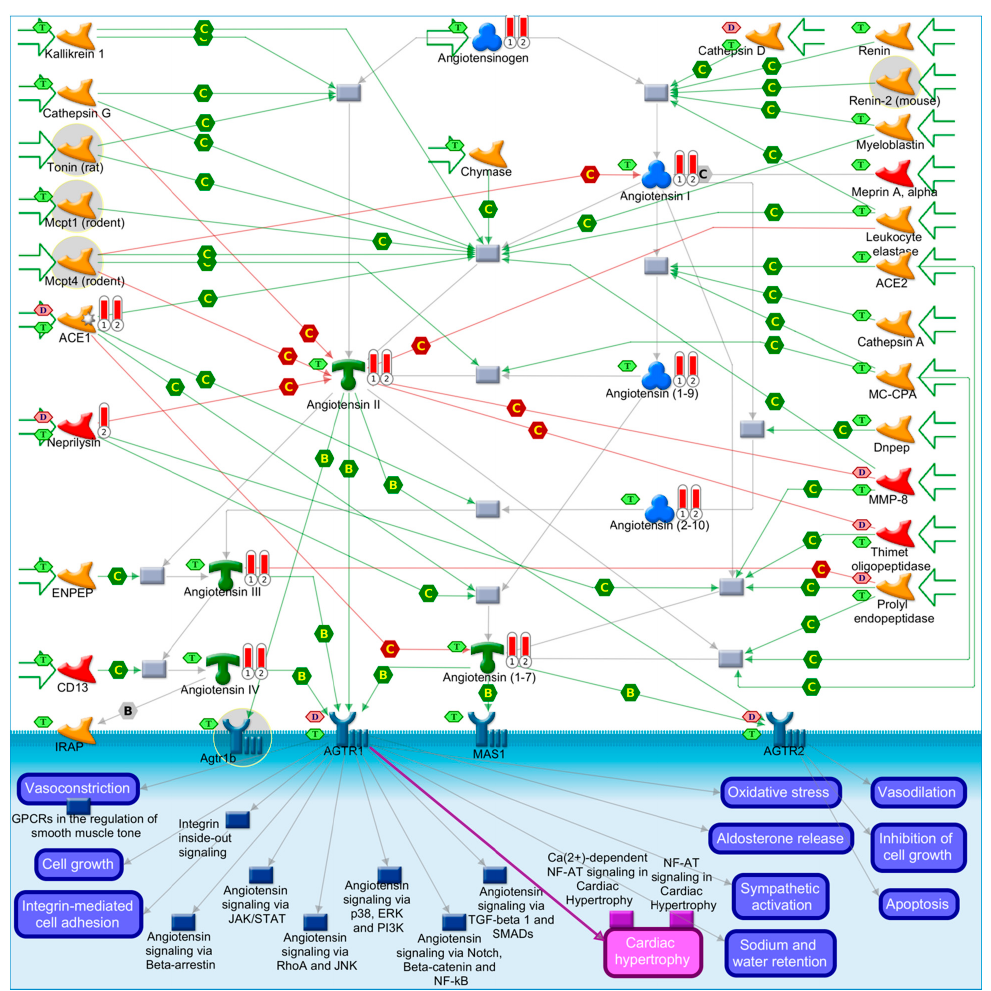
Figure 6. Top enriched pathway map for ‘common’ biomarkers of EOAD and LOAD. The pathway map representing protein-folding and maturation for the angiotensin system maturation. Connec- tions between network objects on the map are referred to as links (or edges). A link identifies an interaction or a logical relation between two nodes. The type of interaction or relation is reflected by an appropriate symbol placed in the middle of the link. B = binding (i.e., physical interaction between molecules); C = cleavage of a protein at a specific site, yielding distinctive peptide frag- ments and carried out by enzymes or compounds; red arrows = inhibition; green arrows = activation; grey arrows = unspecified action; solid purple arrows = emergence in disease; light violet text box = normal process; pink text box = pathological processes; white text box with blue outline = notes; grey block = reaction; blue block = normal process; pink block = pathological process; starred net- work objects = groups or complex processes; red thermometers on pathway map = network object is a validated biomarker for AD, according to the Cortellis Drug Discovery Intelligence (CDDI) da- tabase [40] ; thermometer 1 for EOAD, and thermometer 2 for LOAD; a pink hexagon with a capital D on the upper left side of the network object indicates an AD biomarker according to MetaCore TM ; a green hexagon on the upper left side of the network object with a capital T indicates that the net- work object is expressed in the brain. Map generated using MetaCore TM version 21.4. MetaCore TM , a Cortellis™ solution, 14 October 2022, © 2022 Clarivate. All rights reserved.